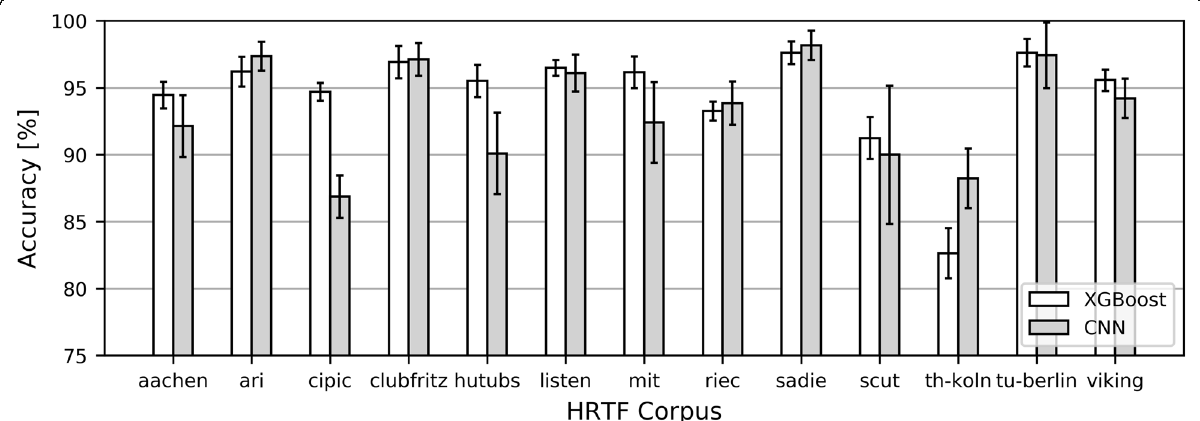
Fig. 14 HRTF-independent test results for separate corpora of HRTFs obtained using the best performing traditional discrimination method (XGBoost) and CNN. Graph shows mean discrimination accuracy scores with associated standard deviations. Acronyms of HRTF corpora are explained in Table 3 in the